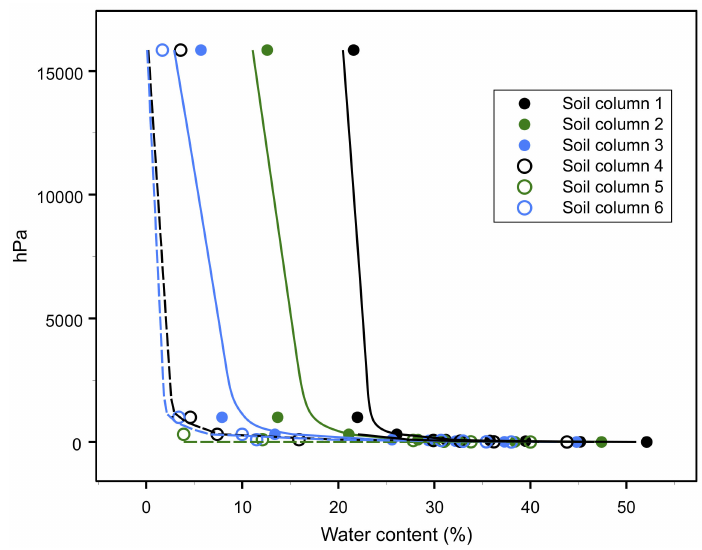
Figure 4. Water retention curves of the six reconstructed soil columns, measured at the laboratory.